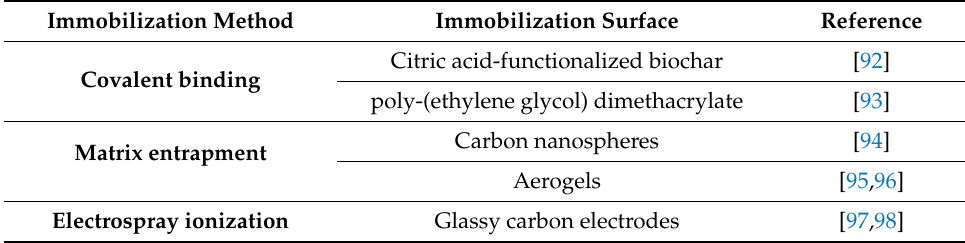
Table 4. Biomediators immobilization